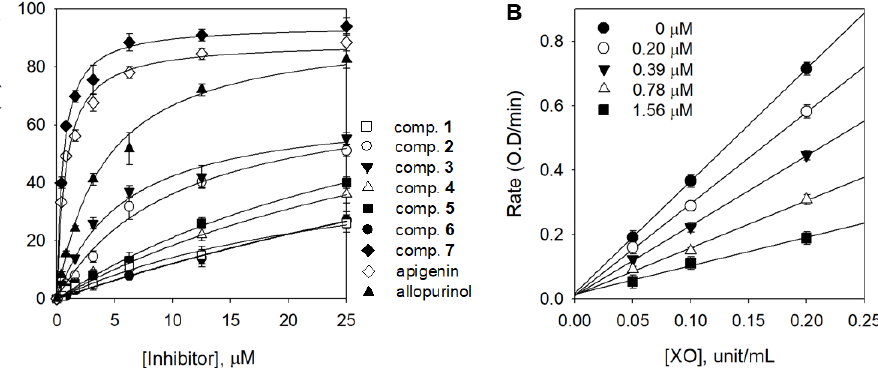
Figure 2. ( A ) Inhibitory effects of compounds ( 1 − 7 ) on the activity of XO based on the oxidation of xanthine to uric acid. ( B ) Reversible relationship of the catalytic activity of XO between enzyme concentrations in compound 7 at different concentrations.